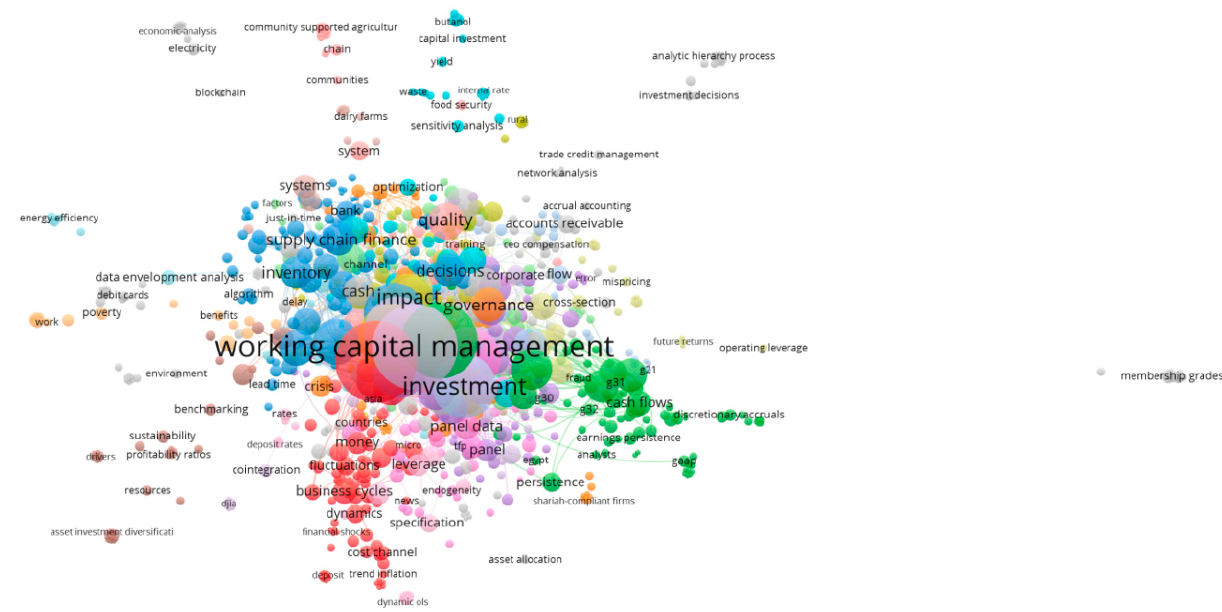
Figure 7. Co-occurrence links and all keywords, considering 1 as the minimum number of occurrences of a keyword and 1000 as the number of keywords selected.